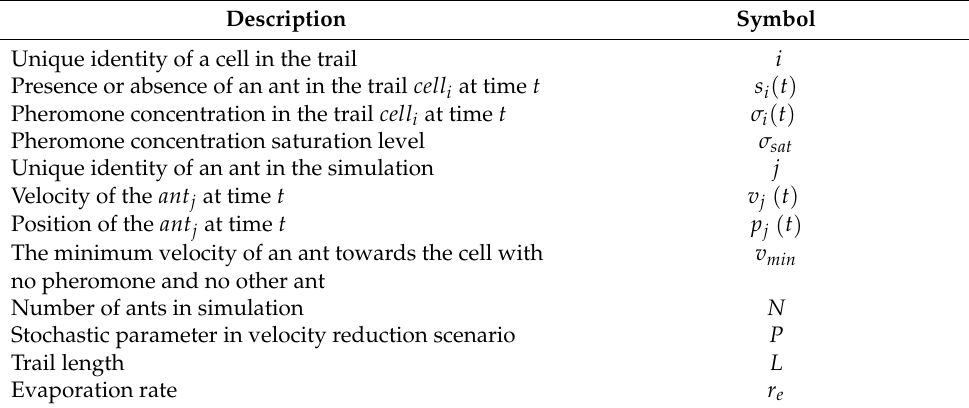
Table 1. An overview of the parameters in the ant-trail model (ATM). Description Symbol Unique identity of a cell in the trail i Presence or absence of an ant in the trail cell i at time t s i ( t ) Pheromone concentration in the trail cell i at time t Pheromone concentration saturation